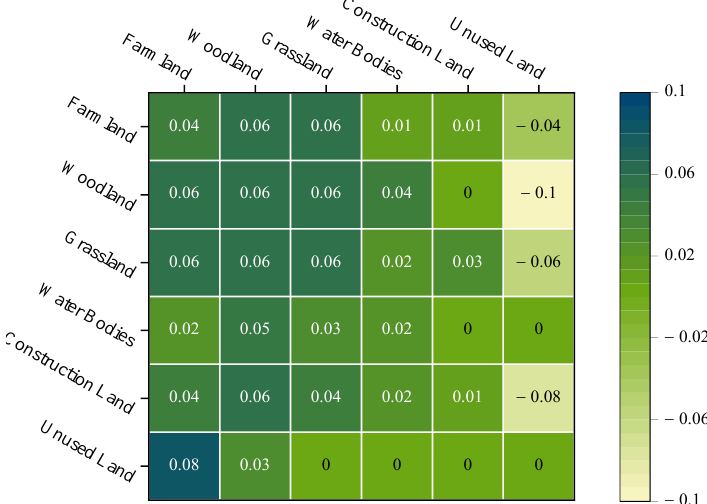
Figure 10. EVI changes of different land use types transferred in Anhui Province from 2000 to 2020 on pixel scale.